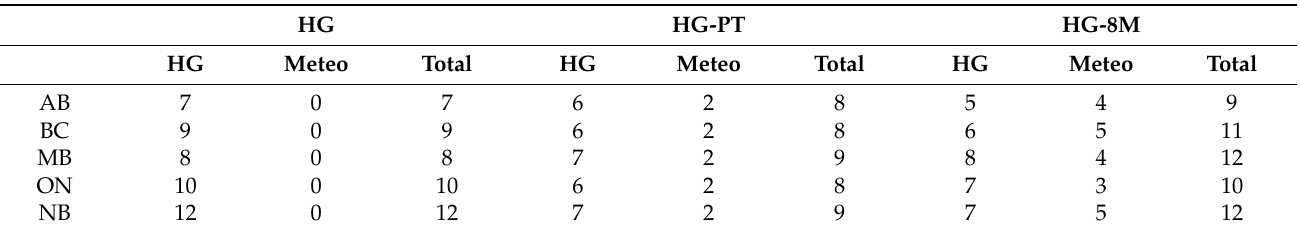
Table 3. Summary of important variables, per VSURF Interp, in each of the study areas, viewed by category, HG (hydrographic, terrain and geomorphology) and Meteo for the meteorological variables (temperature, precipitation, snow,